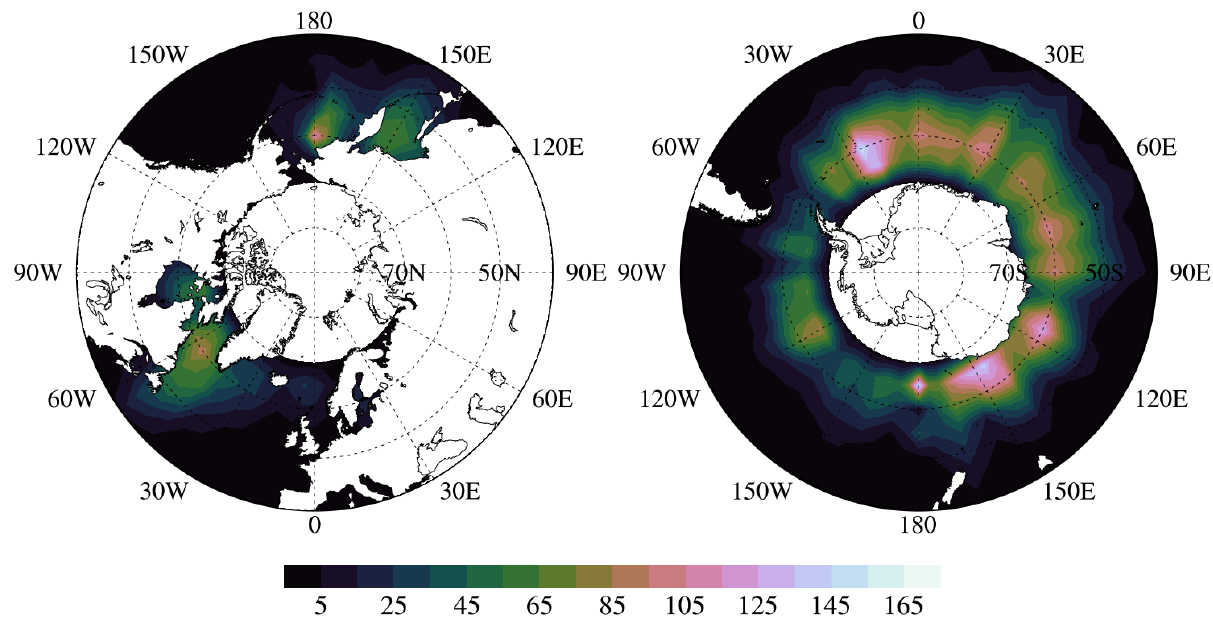
Figure 1. Geolocations of coincident radar profiles for surface snowfall events within 5° × 5° boxes.